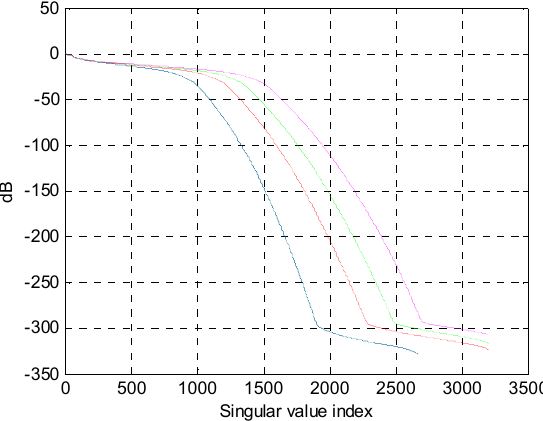
Figure 1. Singular values for increasing observation lines in the parity of the investigation line. The investigation domain is 80 × 80 cm and is centered under the observation line. The observation lines are represented as follows: blue line, observation line, 80 cm long; red line, observation line, 120 cm long; green line, observation line, 160 cm long; cyan line, observation line, 240 cm long. The singular values’ curves are normalized with respect to the maximum singular value.